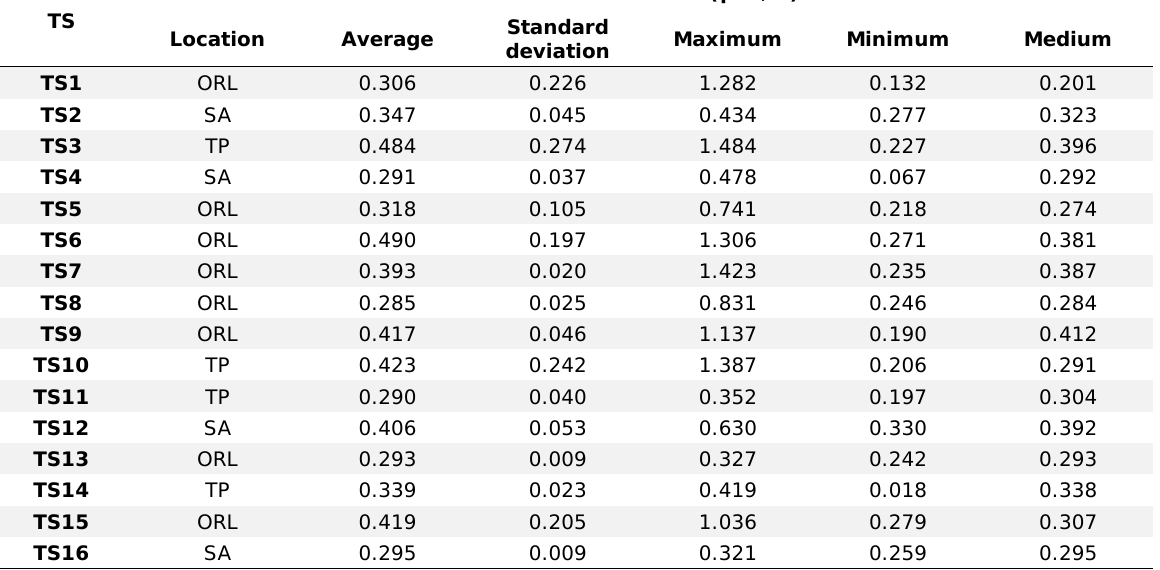
Table 2. Gamma dose rates measurements in the studied thermal spas (TS).